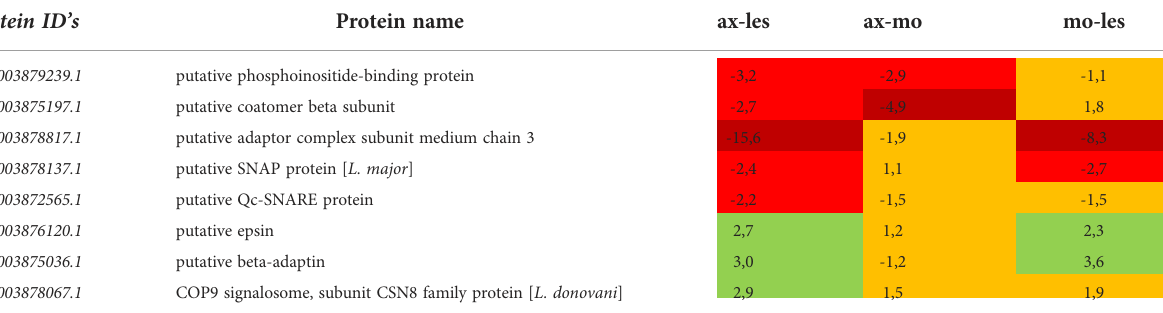
TABLE 8 Vesicular transport proteins identi fi ed in all 3 comparisons that differ by at least 2-fold (T-test signi fi cant) between individual amastigote types. Vesicular transport